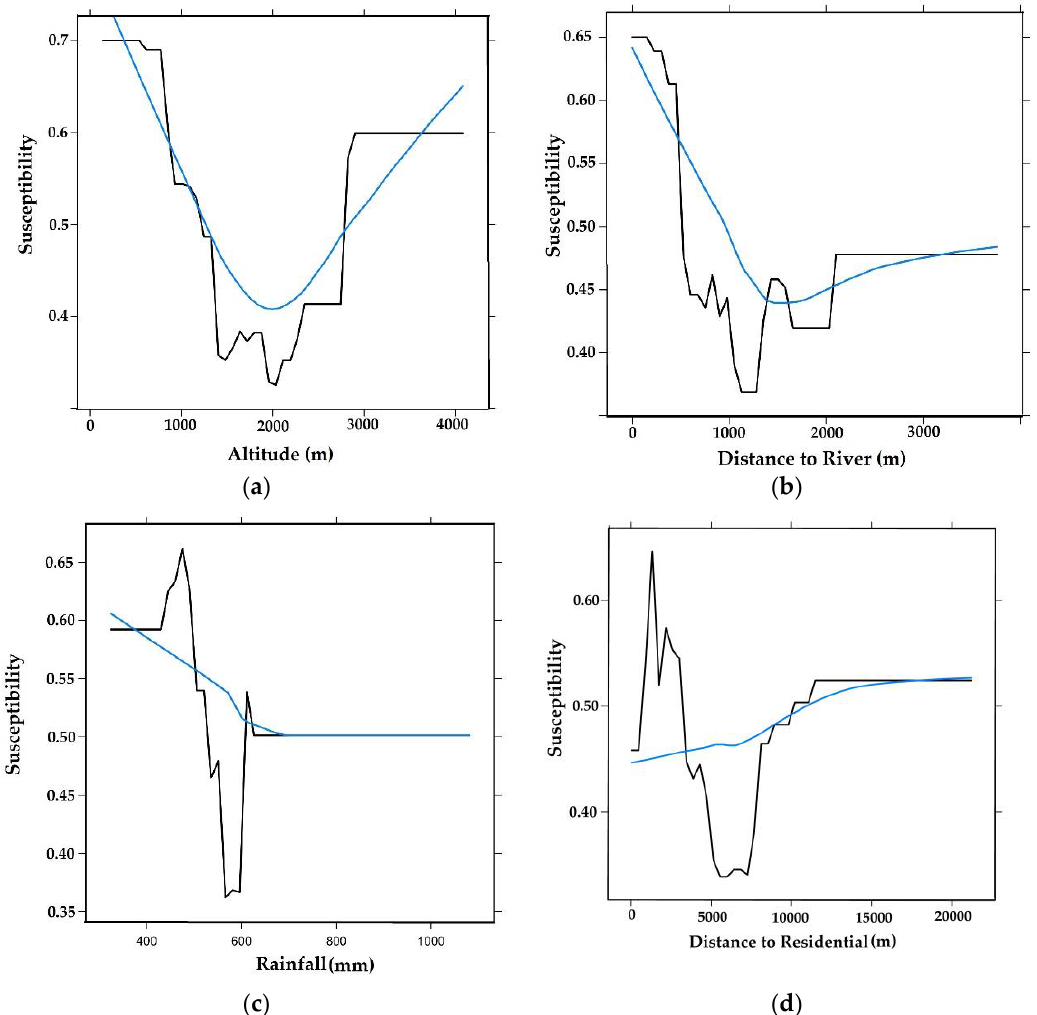
Figure 8. Response curve of variable importance: ( a ) altitude, ( b ) distance from river, ( c ) rainfall and ( d ) distance from residential using the lattice-based PDP.5.